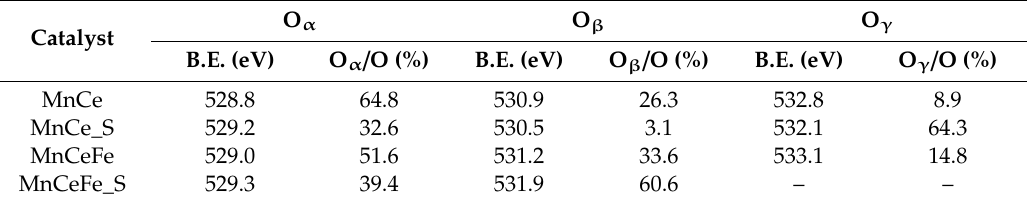
Table 5. O 1s XPS parameters of MnCe, MnCe_S, MnCeFe, and